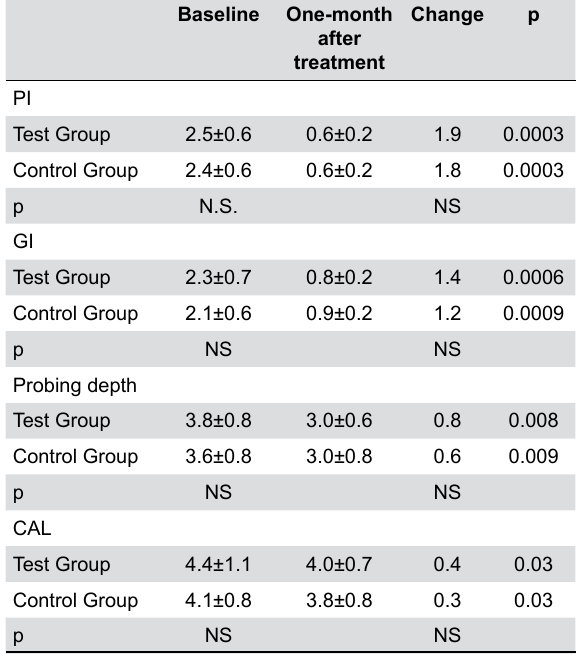
PI=plaque index; GI=gingival index; CAL=clinical attachment level NS=not significant p<0.05; statistically